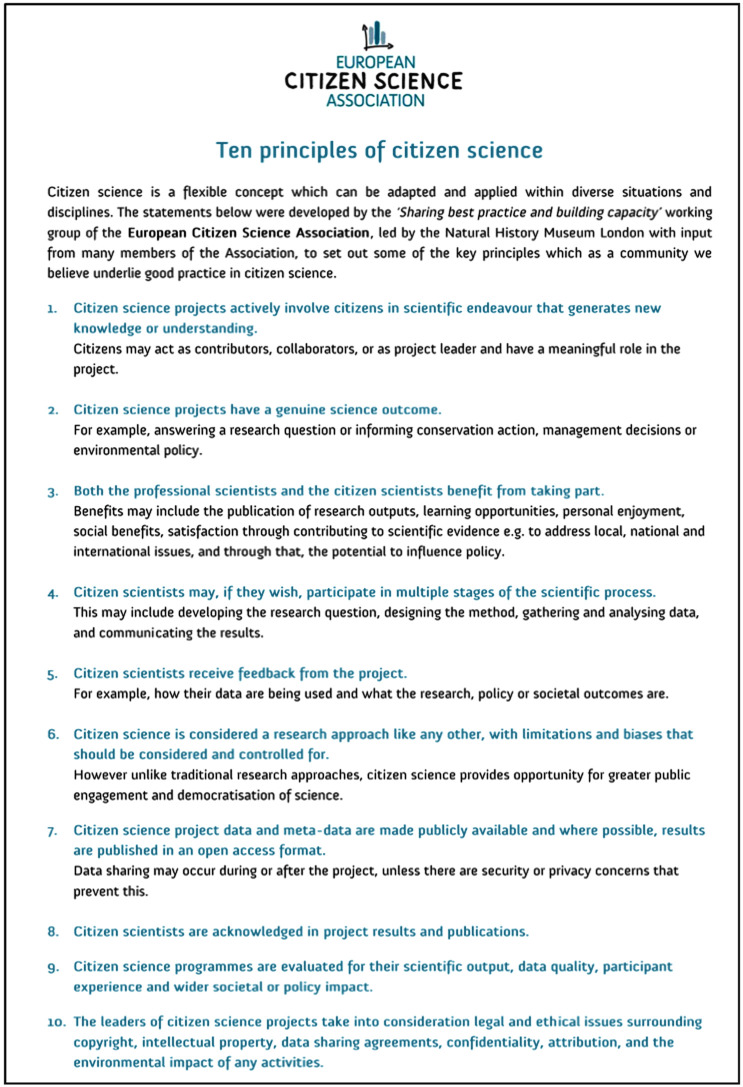
Ten principles of citizen science [39].